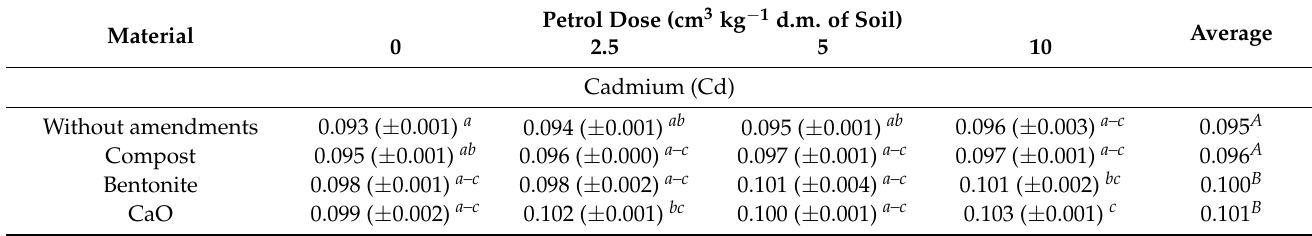
Table 3. Content of cadmium, lead, chromium, nickel, zinc, and copper in aerial parts of maize— Zea mays L. (averages ± standard deviation, mg kg − 1